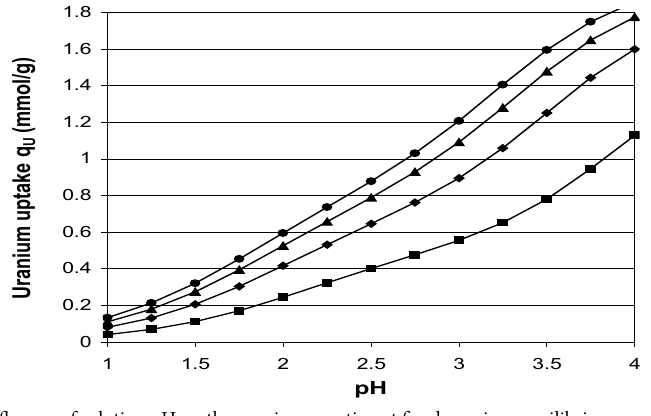
Fig. 6. Influence of solution pH on the uranium sorption at fixed uranium equilibrium concentration (  ) Uf = 6.0 (mmol/g); ( ϭ ) Uf = 4.0 (mmol/g);